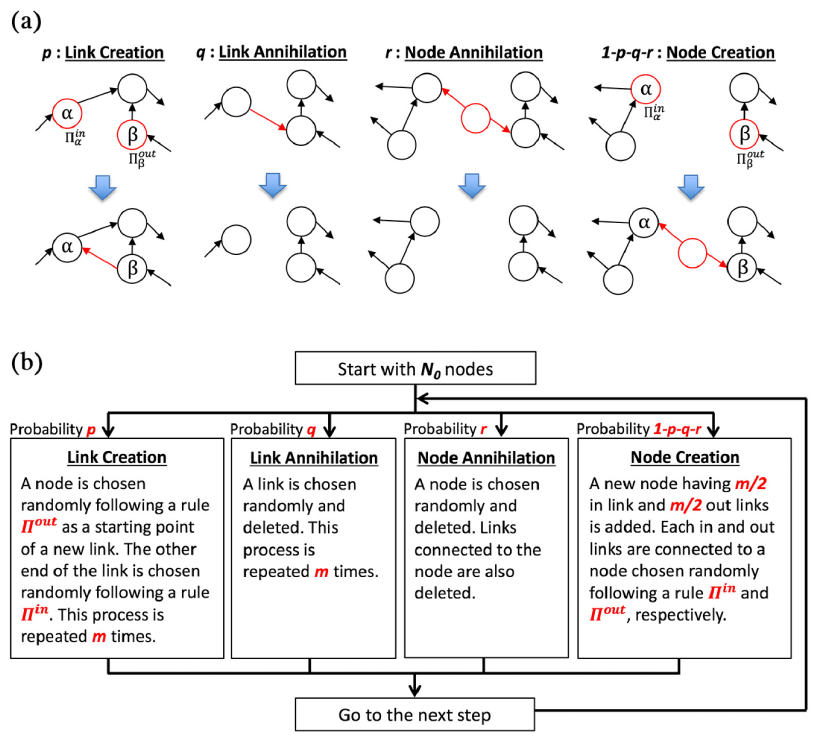
Fig 5. Panel (a) shows the four fundamental processes for nodes: link creations, link annihilations, node annihilations, and node creations in our simulation model. Panel (b) shows a time step flow chart of our simulation model. Each parameter set corresponds to the state of real citation network in Table 4; the occurrence probabilities r p : r q : r r = 0.203: 0.181: 0.301, each the preferential attachment exponent for in-links and out-links is λ